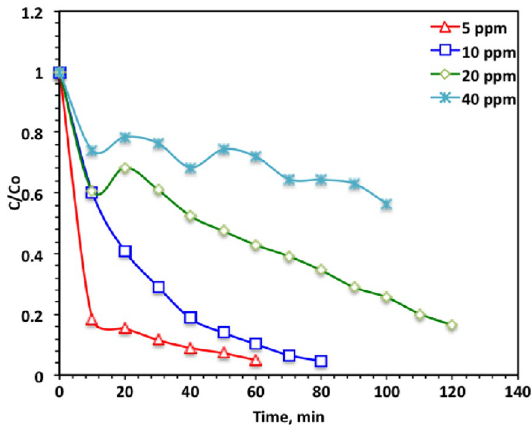
Fig. 5 Effect of various BB9 dye loading in CS-M-based Fenton sys-